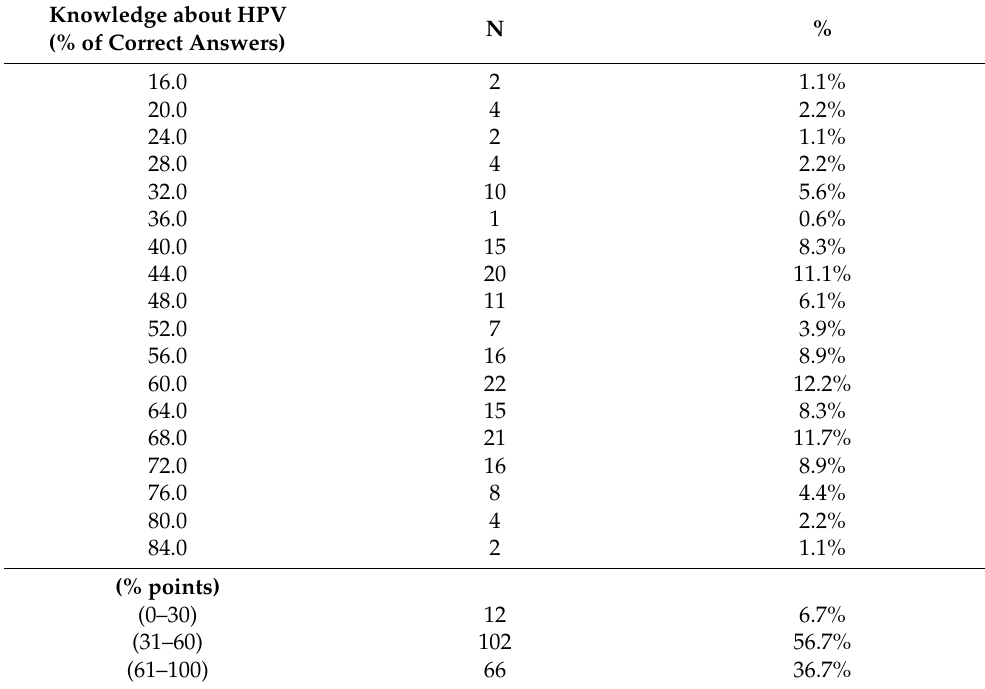
Table 5. Summary test results—knowledge about